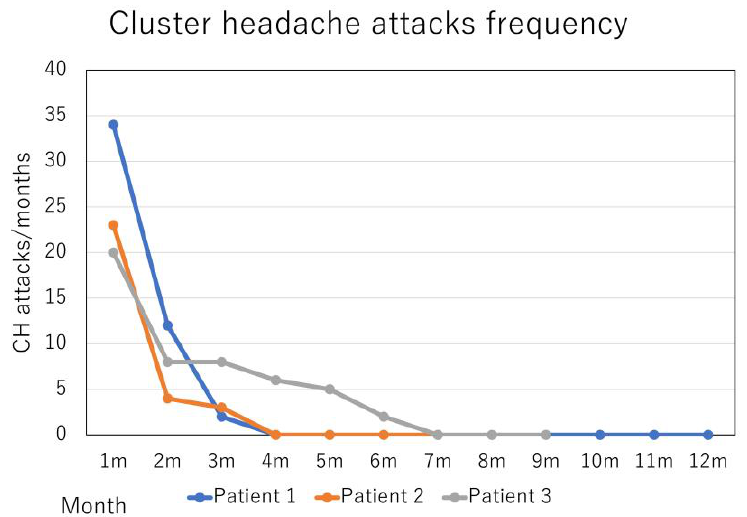
Figure 2. Change in the intensity of cluster headache (CH) attacks in the course of